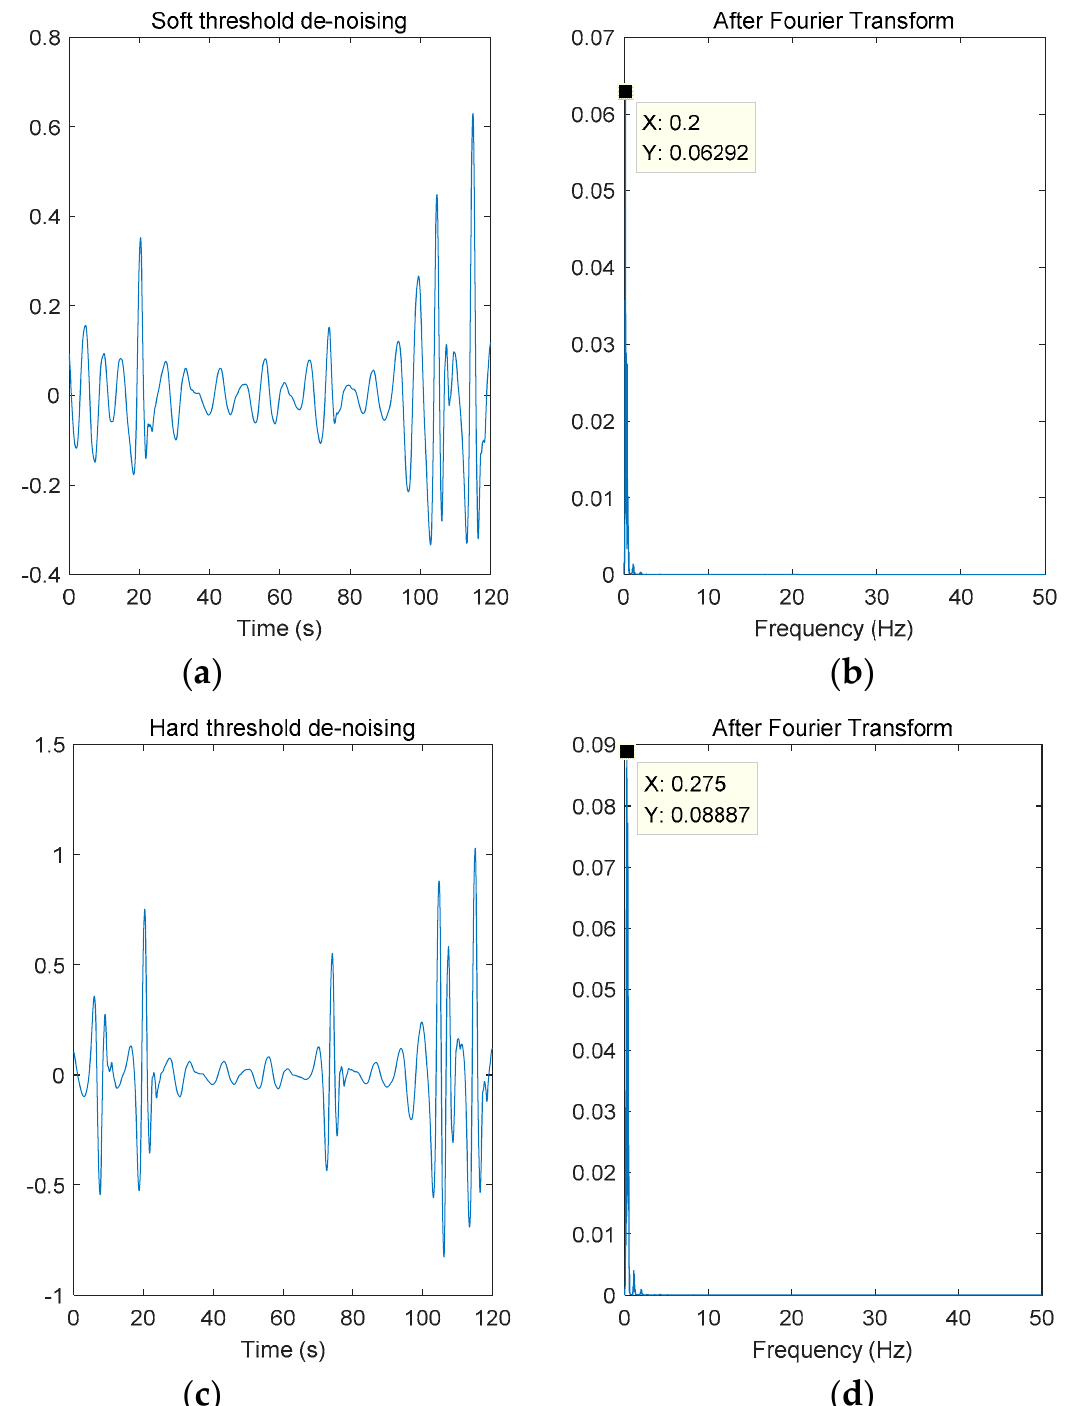
Figure 7. Human respiratory signal after threshold denoising. ( a ) Time domain signal and ( b ) Fourier transform after soft threshold denoising. ( c ) Time domain signal and ( d ) Fourier transform after hard threshold denoising.